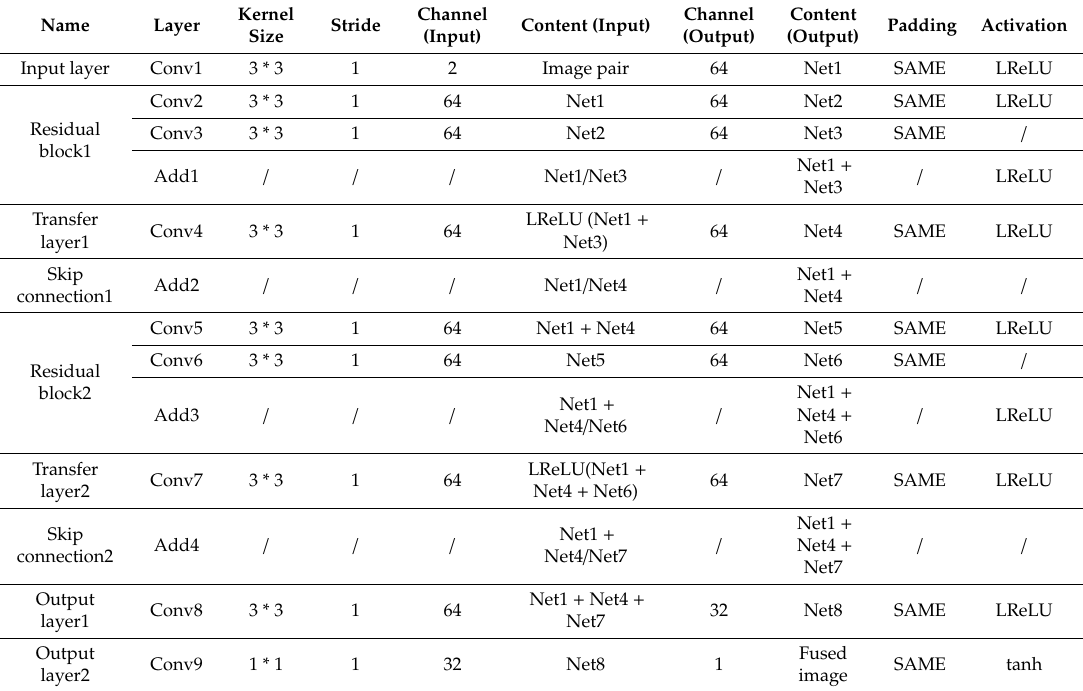
Table 1. The architecture of the generator.